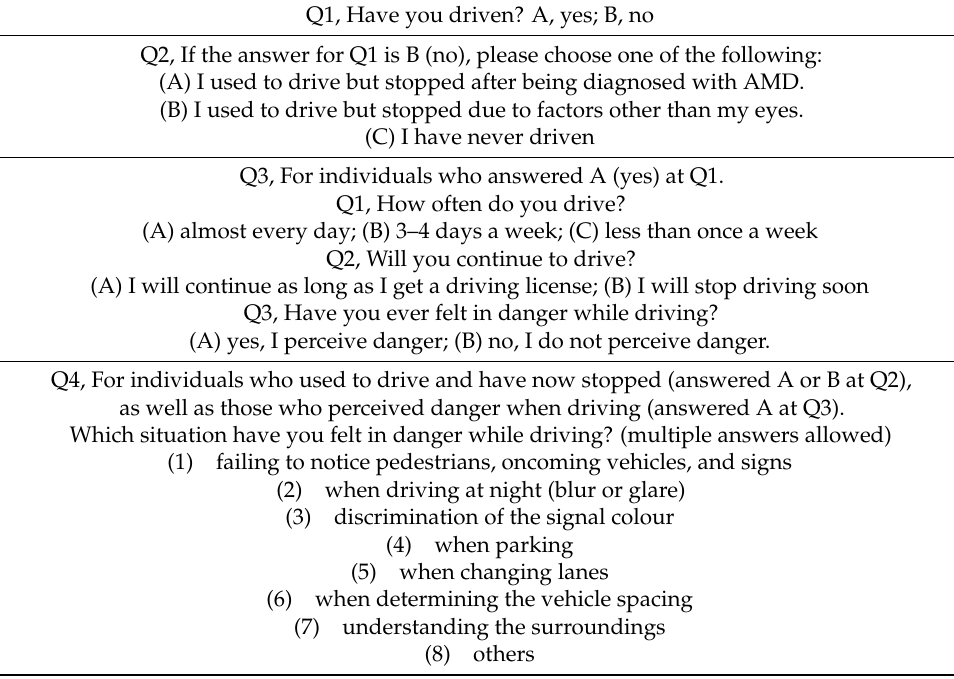
Table 1. Questionnaire